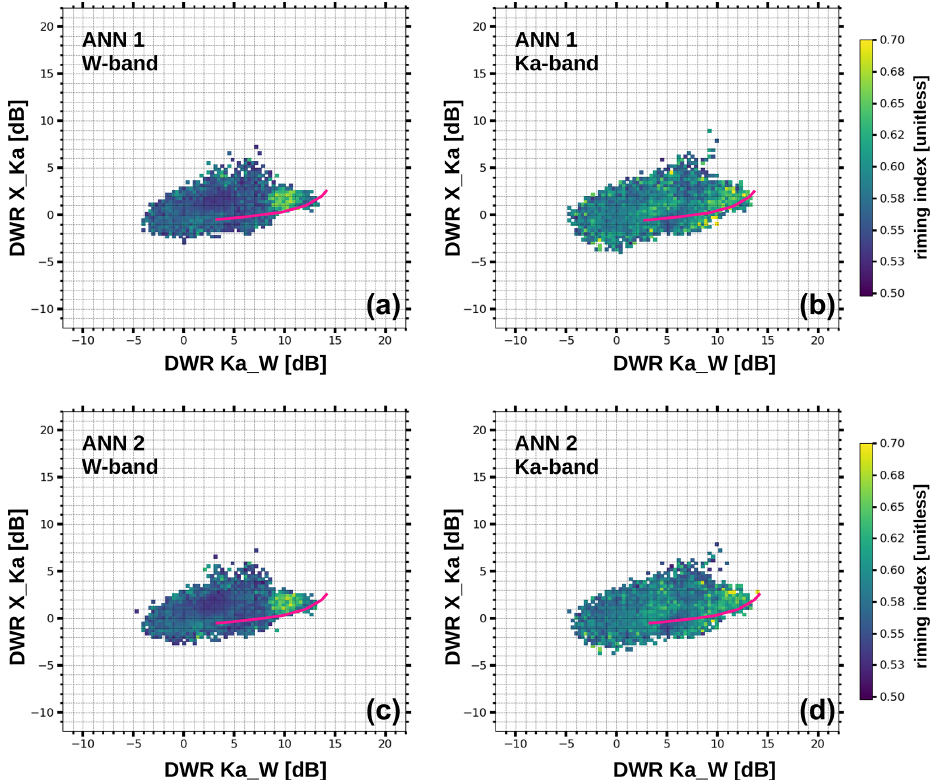
Figure 7. The 2D histograms for seven cases, chosen from the TRIPEx-pol data set, where the rime index > 0.5 was predicted. Each pixel contains at least 10 observations, and the color indicates the median FR ANN of all the observations contained in the pixel. FR ANN predicted using the W band (a, c) , and Ka-band (b, d) radar observations are displayed. The pink line is drawn where rimed particles are expected (according to Fig. 15 in Kneifel et al.,